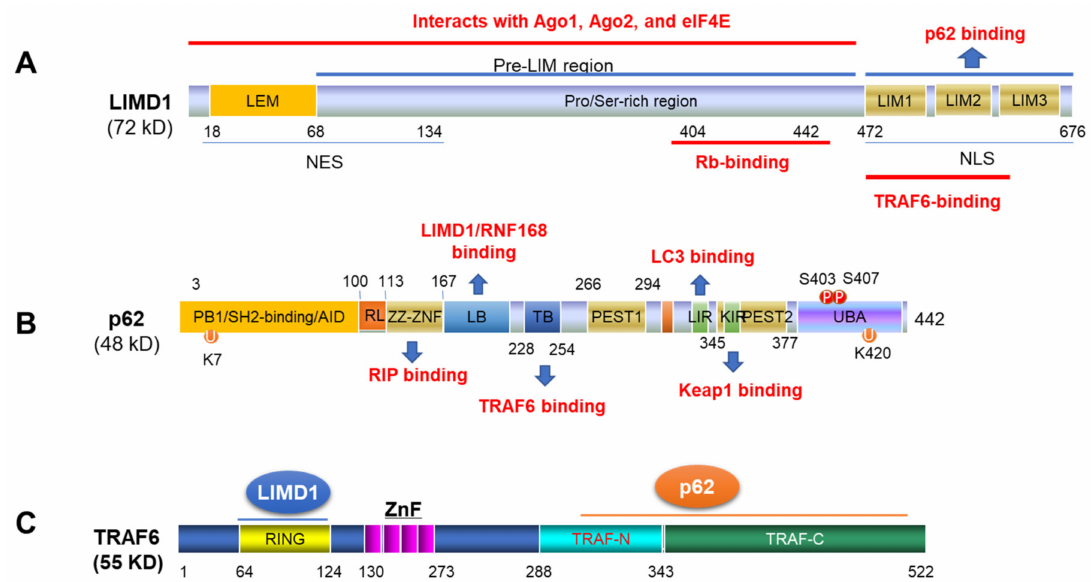
Figure 2. Domain schemes of LIMD1, p62 and TRAF6. The domains of LIMD1 ( A ), p62 ( B ) and TRAF6 ( C ) for their interactions are shown. NES: nuclear export signal; NLS: nuclear localization signal; PB1: Phox/Bem 1p protein–protein binding domain; AID: atypical PKC interacting domain; RL: regulatory linker; ZNF: Zinc finger; LB: LIM protein binding; TB: TRAF6 binding; LIR: LC3-interacting region that mediates interaction with ATG8 family; UBA: Ubiquitin-binding re-gion that binds specifically to K63-linked polyubiquitin chains of polyubiquitinated substrates; NES: nuclear export signal. NLS: nuclear localization signal; ZnF: Zinc